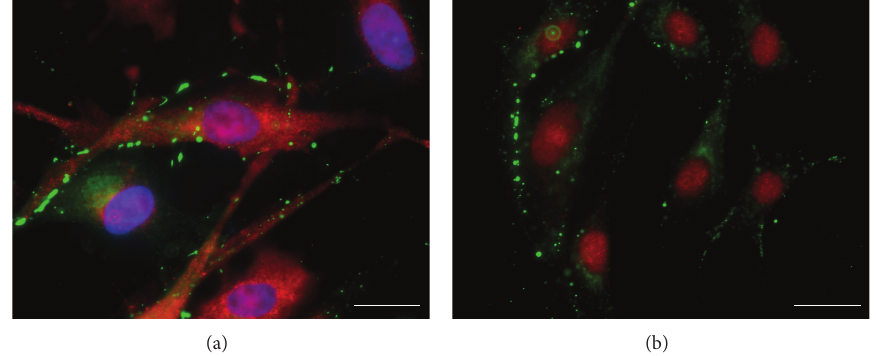
Figure 1: Characterization of rabbit SkMs. (a) Immunostaining of desmin (red) and endogenous Cx43 (green). Nuclei are labeled with DAPI (blue). (b) Immunostaining of myogenin (red) and endogenous Cx43 (green). Scale bar 20 𝜇 m.